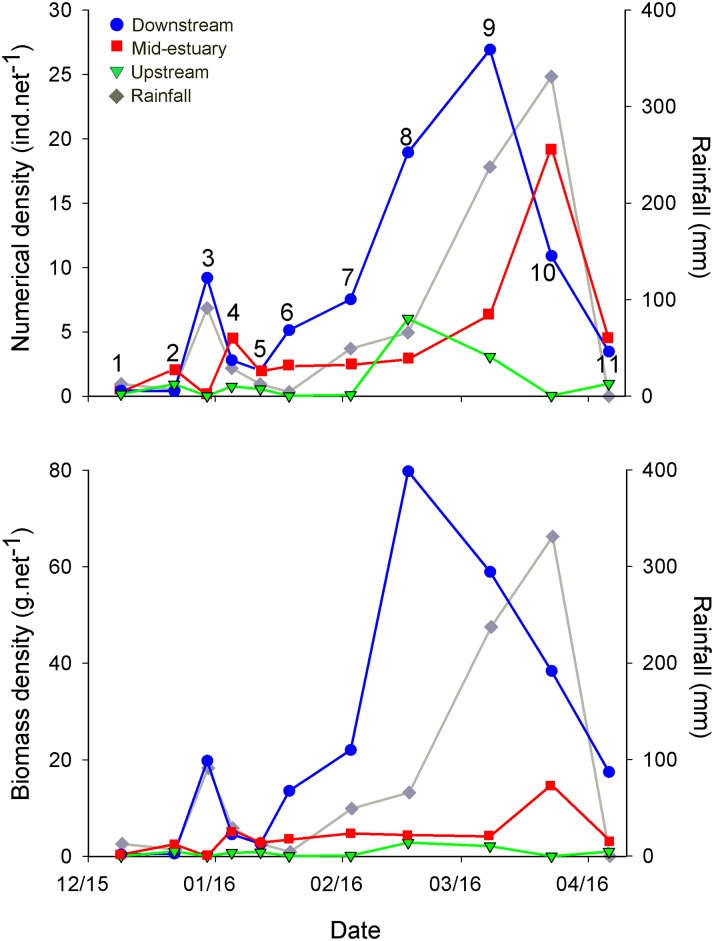
F. merguiensis density and biomass.Mean (arithmetic mean) numerical density (top) and biomass density (bottom) of F. merguiensis in Alligator Creek over the 2015–2016 wet season, and rainfall recorded for Townsville (the closest weather station, ~27 km away) for the same period (Bureau of Meteorology, www.bom.au, accessed 09/02/17). For rainfall, values correspond to the total rain (mm) that fell between the respective date and the previous sampling trip, apart from trip 1, for which rainfall of the previous 15 days is indicated. Trip numbers are indicated in the top panel.